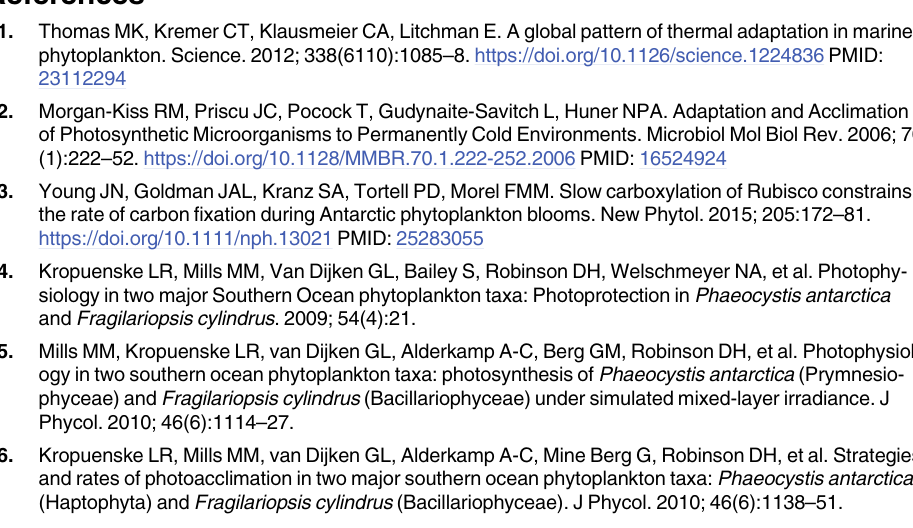
S10 Fig. Data points. Data from: “Photoacclimation of the polar diatom Chaetoceros